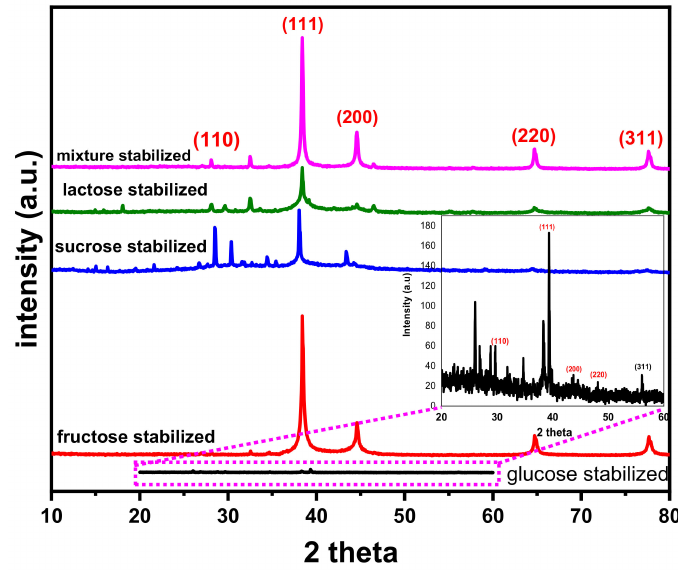
Figure 7. XRD spectra of AgNPs stabilized with pure and mixture of stabilizers. Table 4. Crystallite size of AgNPs stabilized with pure and mixed